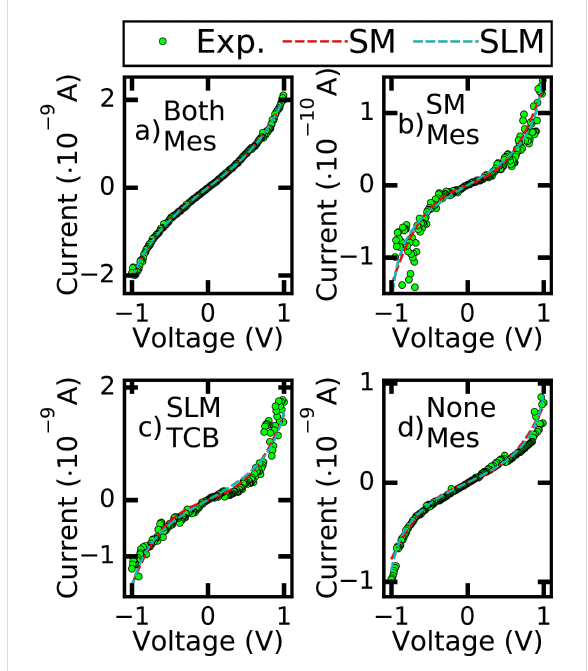
Figure 4: Examples of I – V s and their best-fittings to the SLM and the SM. a) Fitting with both models, | E 0 | = 0.867 ± 0.008